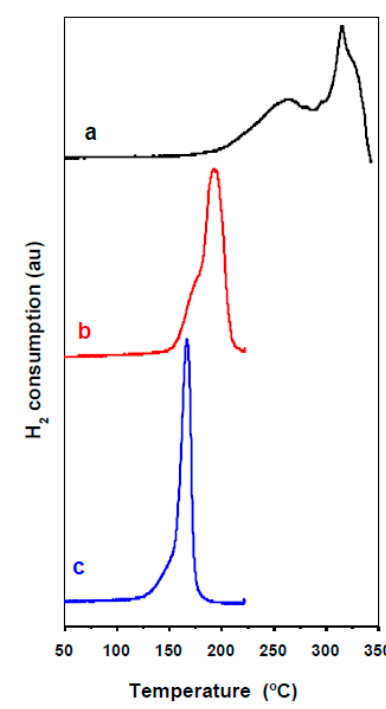
Figure 6. Temperature programmed reduction profiles of calcined catalysts: ( a ) CuO / ZnO-Al-W / O ( − ), ( b ) CuO / ZnO-Al-W1 ( − ), ( c ) CuO / ZnO-Al-W3 ( − ).